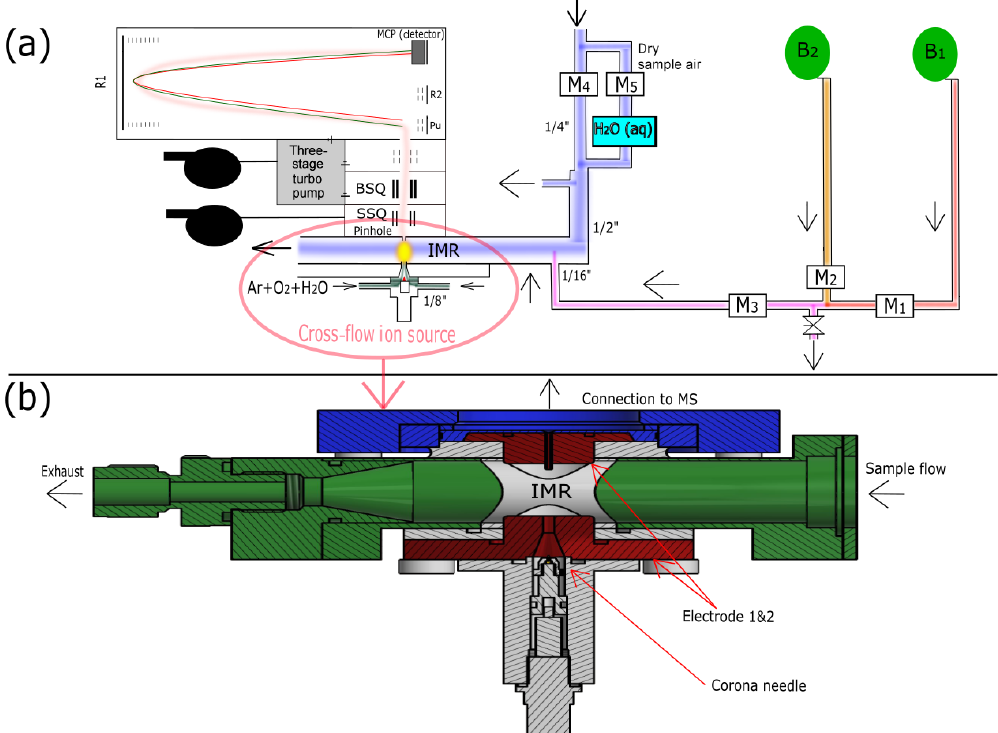
Figure 1. The experimental setup of the water cluster CI-APi-TOF during ammonia calibration is shown in panel (a) . Blue indicates the sample flow. It consists of a mixture of 80% nitrogen and 20% oxygen. A portion of the sample flow can be humidified with a water bubbler (H 2 O aq ) to achieve different relative humidities. B 1 represents the ammonia gas bottle, while B 2 represents a gas bottle containing pure nitrogen. There are five mass flow controllers (MFCs; labeled as M 1–5 ) allowing two dilution steps. Three MFCs (M 1 , M 2 , M 3 ) control the amount of ammonia that is added through a 1 / 16 (cid:48)(cid:48) capillary into the center of the sample flow, where the second dilution stage occurs. The reagent ions (i.e., protonated water clusters) are produced when the ion source gas (argon, oxygen, water vapor) passes a corona needle at a positive high voltage (detailed in panel b ). The calibration setup is disconnected during the measurements at the CLOUD chamber to reduce backgrounds (leakage from the 1 / 16 (cid:48)(cid:48) capillary). Details of the ion source used during CLOUD13 are shown in panel (b) . The primary ions are guided towards the sample flow using a counter electrode (Electrode 1). Additionally, a funnel is used to accelerate the primary ions towards the sample flow. A second electrode (Electrode 2) is installed directly in front of the pinhole of the mass spectrometer. The ions enter the mass spectrometer through a capillary on the top of Electrode